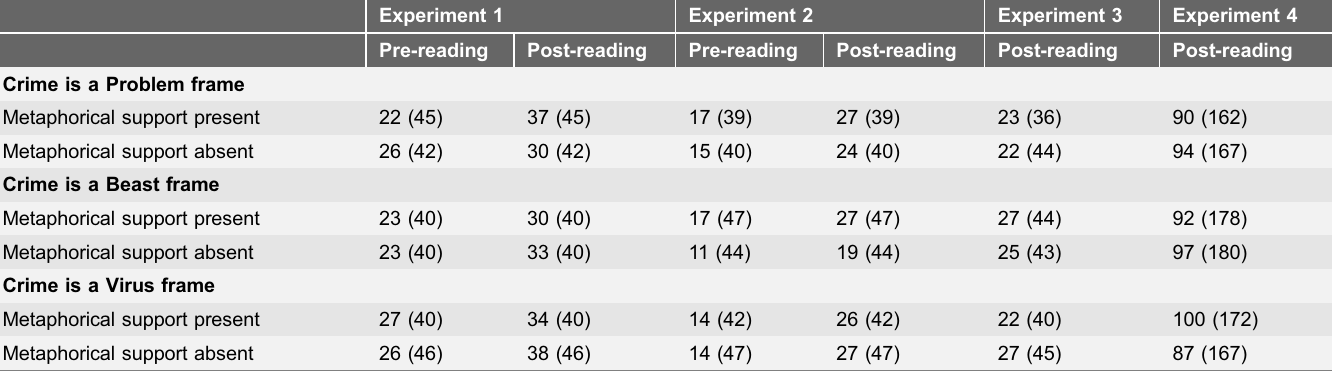
Table 3. Number of participants (and total N per condition) who showed preference for enforcement (over reform) solutions, as a factor of the metaphorical framing (problem, beast, virus), metaphorical support (present, absent) and, for Experiments 1–2, exposure (pre or post-reading of stimulus